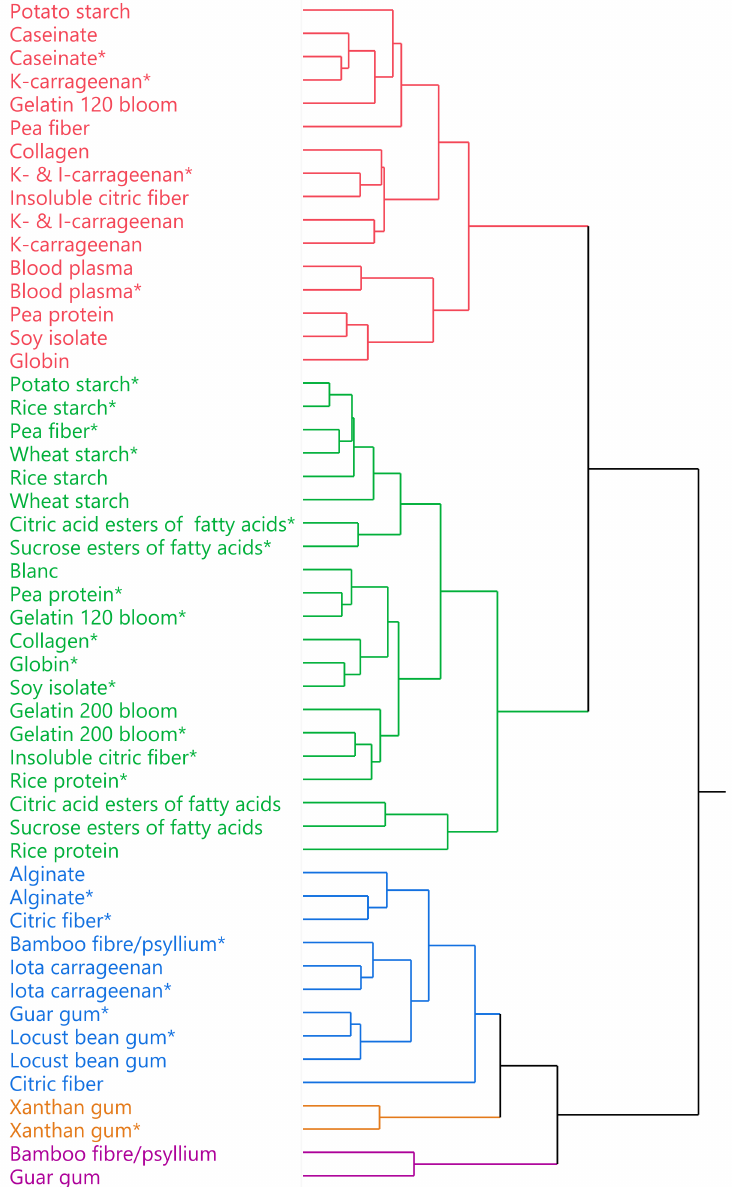
Figure 2. Dendrogram based on hierarchical cluster analysis of 25 screened ingredients at 2 dosages. Ingredient x dosage combinations occurring in same color have similar properties and belong to same cluster. ‘*’ means ingredient is tested at low dosage. Dosage is product class-dependent, as indicated in Table